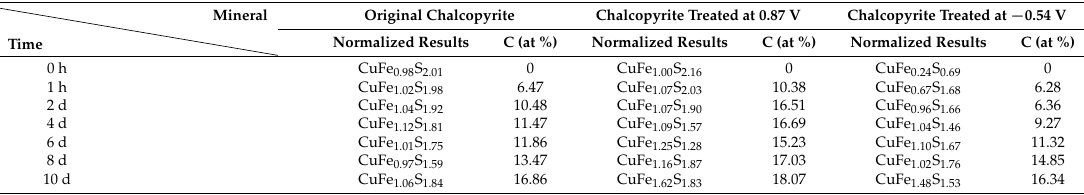
Table 1. The normalized energy dispersive spectroscopy (EDS) results of Cu, Fe, and S and atom percent (at %) of elemental carbon (C) for different chalcopyrite surfaces at different leaching time on creviced area.